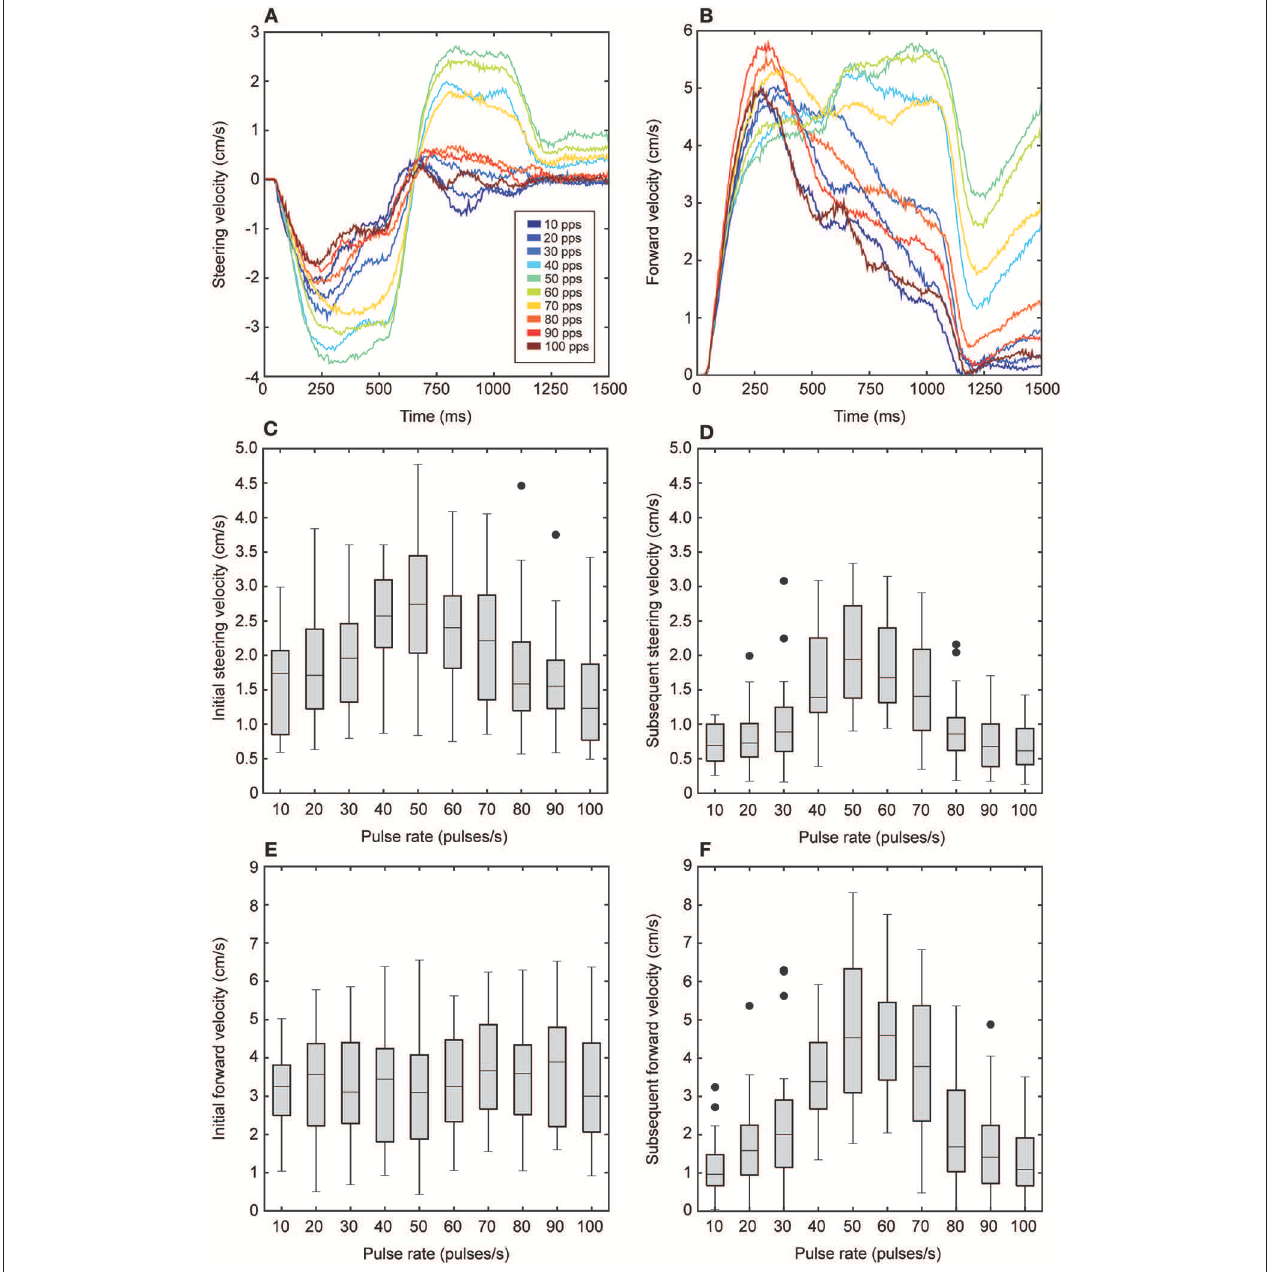
FIGURE 4 | Effects of song pulse rate on steering and forward velocities. (A) Flies steered to the left to track the initial 500ms of song broadcast. This was followed by a steering response to the right to track the switch in broadcast location for the remaining 500ms of song. The magnitude of steering responses varied with song pulse rate (colors). Steering to the initial broadcast location was less selective while steering to the subsequent location showed greater selectivity to songs with pulse rates that range from 40 to 70 pps. In response to the initial broadcast location, flies exhibited an increase in forward velocity (B) that varied as a function of song pulse rate. When the song was switched to the subsequent broadcast location, forward velocity continued to be elevated for the most preferred pulse rates (40–70 pps) but decreased for less preferred pulse rates. (C–F) Box plots depict the first and third quartiles and median steering (C,D) and forward velocity (E,F) values at 250 and 750ms time points in response the initial (C,E) and subsequent (D,F) broadcast locations as a function of song pulse rate. In response to the initial broadcast location, mean steering velocity varied with pulse rate (C) while mean forward velocity did not vary with pulse rate (E) . Flies exhibited greater selectivity in response to the subsequent broadcast location. Steering (D) and forward (F) velocities reached peaked at the most preferred pulse rates. Whiskers in box plots show the most data extreme points that are not considered outliers, and closed circles indicate outliers.